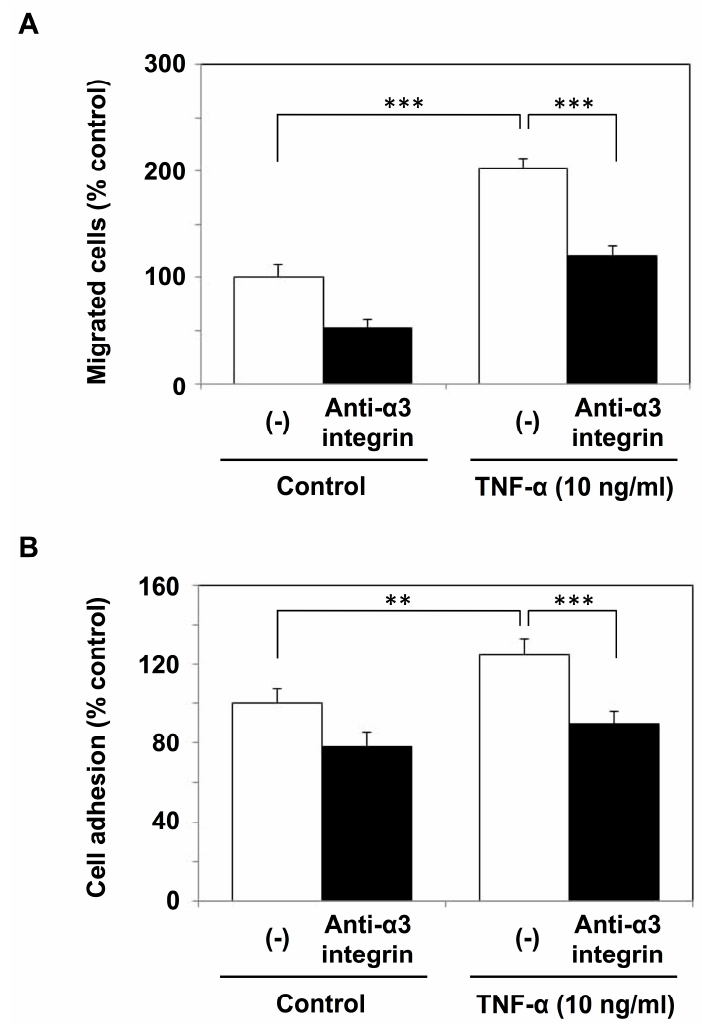
Figure 5. Invasion and adhesion of MKN1 cells and effects of the anti- α 3 integrin antibody. A monolayer of mesothelial cells was stimulated with TNF- α (10 ng/mL) for 6 h. ( A ) MKN1 cells (1 × 10 5 cells/0.2 mL) in ASF104 serum-free medium were added to the inner chamber of the reconstituted mesothelium and incubated at 37 ◦ C for 16 h. The cells that had migrated into the outer chamber through the membrane were counted under a microscope. ( B ) Fluorescently labeled MKN1 cells were added to the monolayer of mesothelial cells in a 96-well culture plate, and incubated at 37 ◦ C for 40 min. After non-adherent cells were removed by washing, adherent cells were lysed with 1% Nonidet P-40 and measured with a fluorescence spectrophotometer (Ex = 490 nm, Em = 520 nm). For the inhibition experiments, MKN1 cells were treated with the anti- α 3 integrin antibody (SM-T1, 10 µ g/mL) at 0 ◦ C for 30 min. Experiments were performed in triplicate, and the data are presented as the mean ± SEM. Statistical data analysis was conducted using the Student’s t -test. ** p < 0.01, *** p < 0.005.